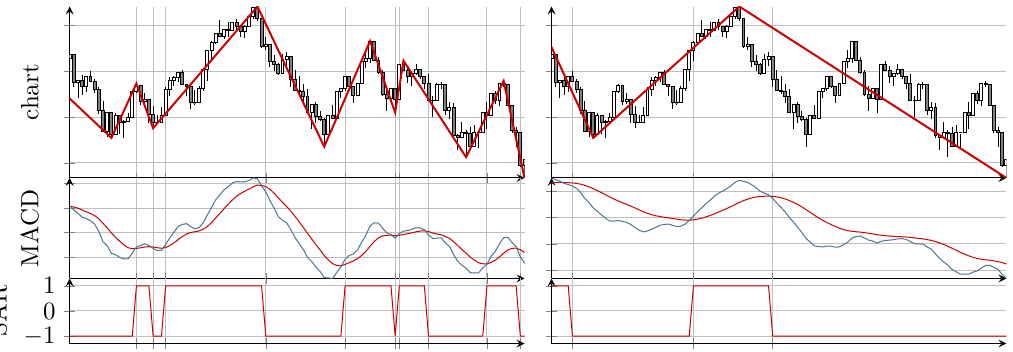
Figure 1. Two examples showing for the MinMax series and the underlying SAR (stop and reverse) process derived from the MACD (moving average convergence/divergence) indicator for two different choices of “timescale”: parameter (12,26,9), i.e., timescale = 1 (left) and parameter (30,65,22.5), i.e., timescale = 2.5 (right). Both examples show the exact same time frame of the S&P